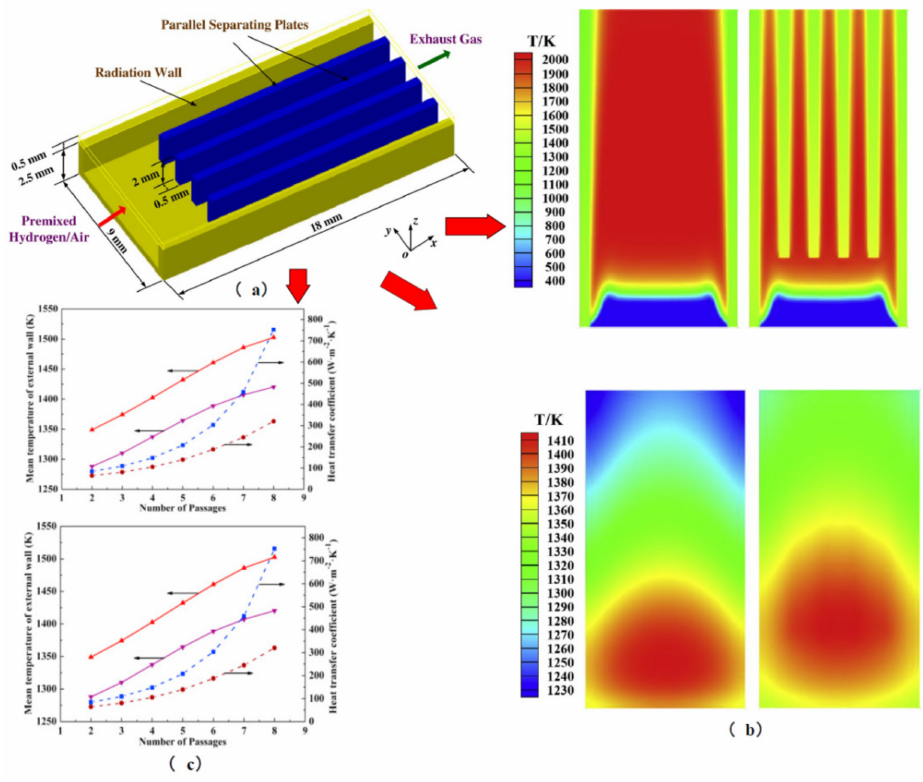
Figure 24. Micro planar combustor schematic diagram, temperature distribution, Heat transfer coefficient and Mean temperature of external. ( a ) Combustor schematic diagram, ( b ) Temperature distribution, ( c ) Mean temperature of external and Heat transfer